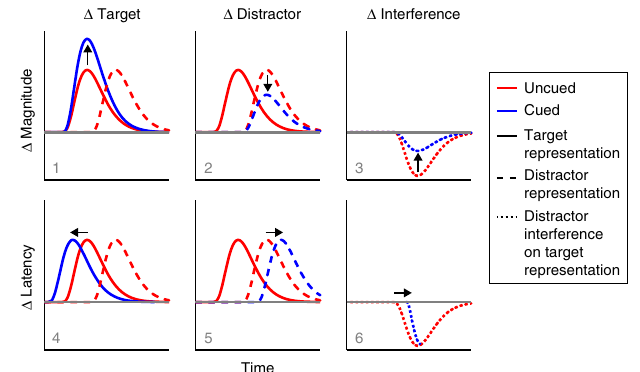
Fig. 3 Schematic of ways in which anticipation may prioritise relevant over irrelevant sensory inputs that compete in time. We consider six non- mutually exclusive scenarios. Anticipation can in fl uence the target representation (left), the distractor representation (middle) or the interference on the target representation when distractors are present compared to absent (right). This in fl uence can be manifest either as a change in magnitude ('representation strength') or a change in latency ('representation timing'). We fi nd evidence for scenarios 1 (increased target identity decoding) and 6 (delayed distractor interference on the target identity Figure 2a shows the time-resolved tuning pro fi les separately for all targets without a distractor (left), all targets with a distractor (middle), as well as for all distractors (right). Clearly, neural responses evoked by the targets (left two panels) and the distractors (right panel) are more similar to other targets/ distractors that have similar orientations (red), relative to other targets/distractors that have dissimilar orientations (blue). Thus, despite that fact that the latter two conditions always contained two stimuli in close temporal succession, both target and distractor identities (which were drawn independently of each other across trials), were decodable with high temporal resolution from the EEG.